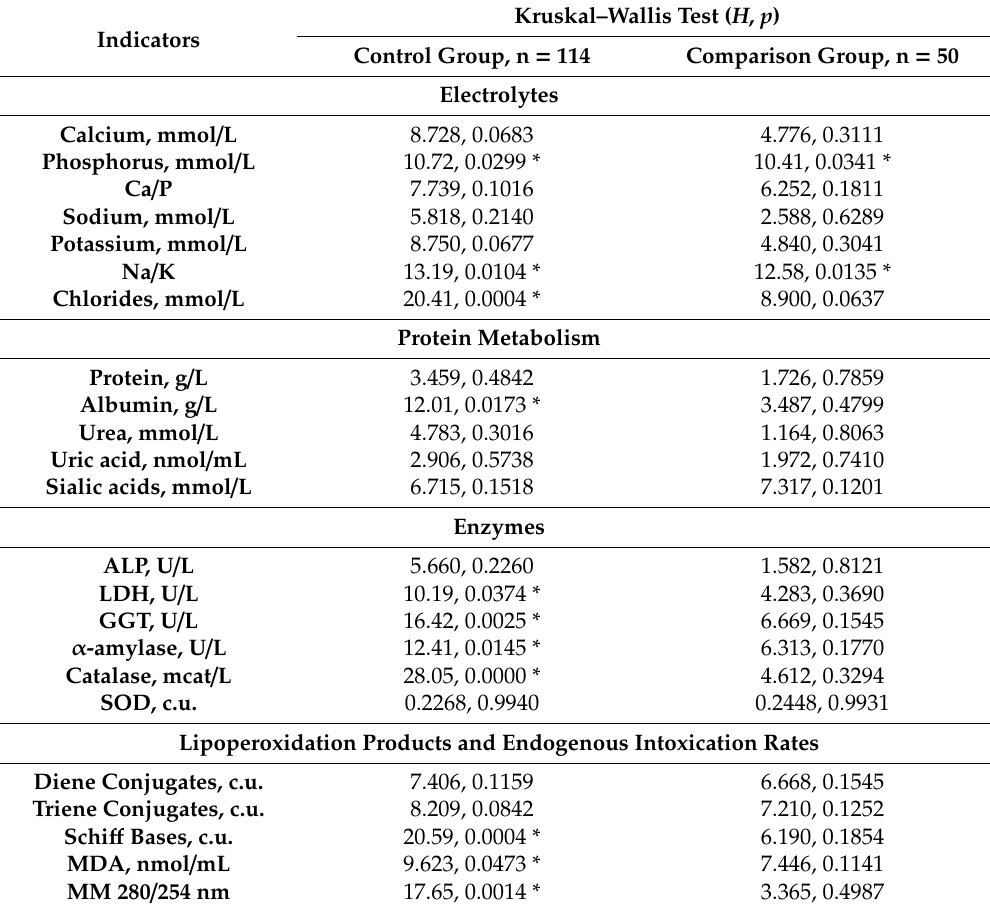
Table 3. The values of the Kruskal–Wallis criterion when comparing patients with OSCC by stages with a control group and a comparison